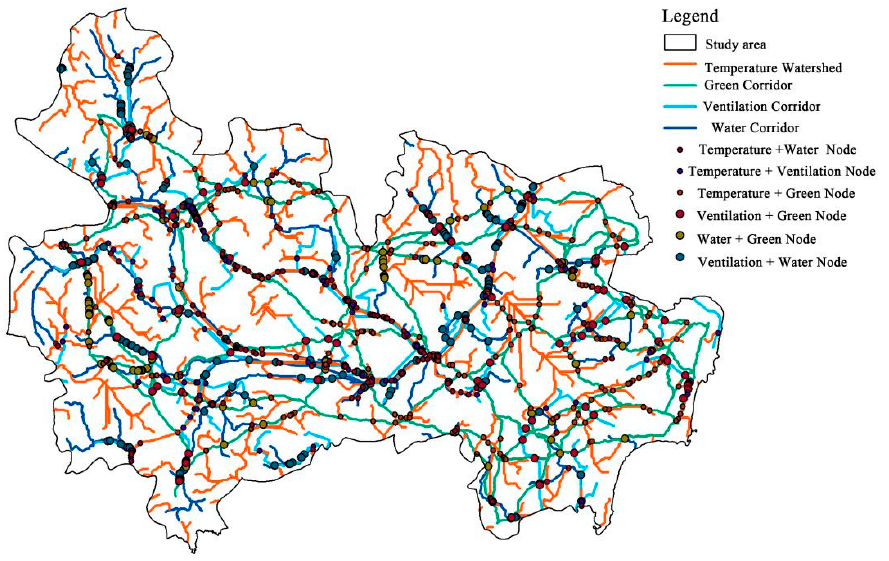
Figure 3. Corridors overlayed: ecological node distribution. Table 2. Corridors overlayed: ecological node distribution statistics.